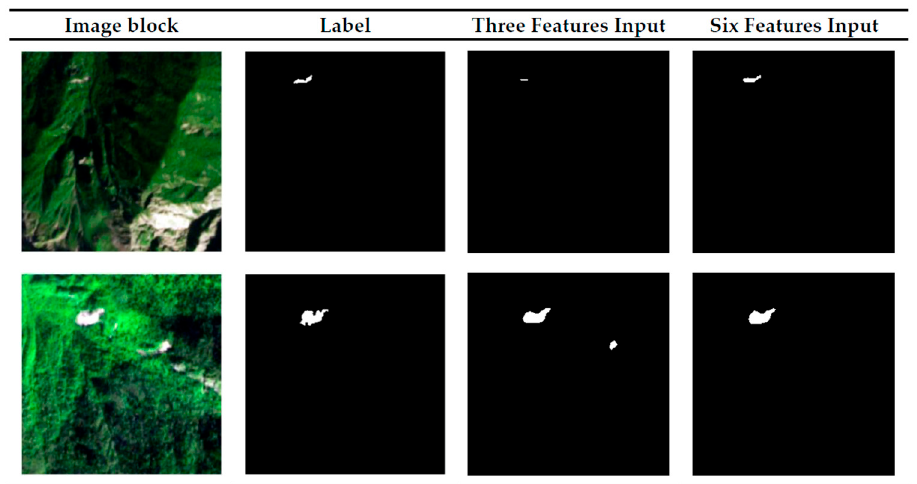
Figure 12. Comparison results of the same model for different input features.